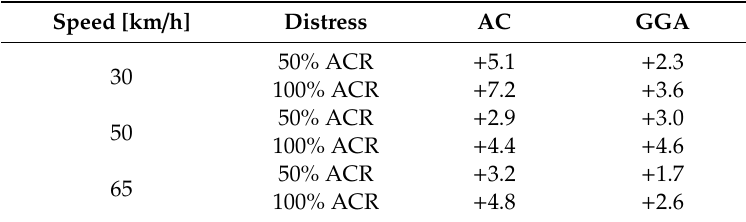
Table 6. Increase of the average noise levels by distress percentage for AC and GGA [dBA]. Speed [km / h] Distress